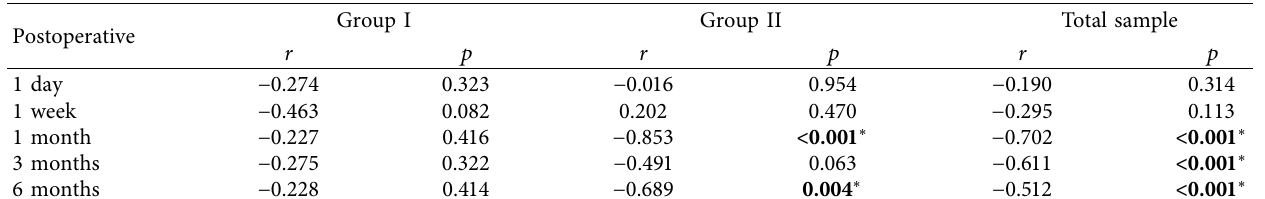
Table 7: Correlation between maximal bleb wall thickness and intraocular pressure in studied